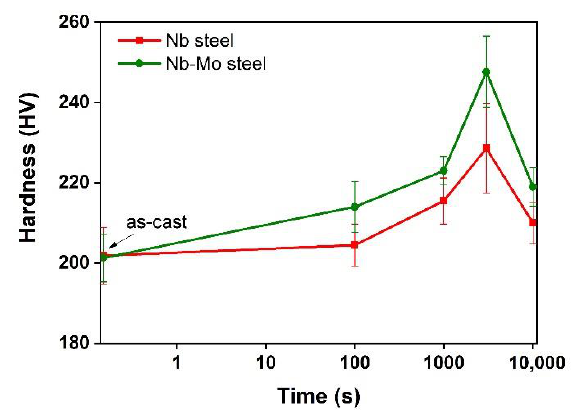
Figure 2. Hardness evolution of the niobium (Nb) and Nb-Mo steels during heat treatment at 900 °C.